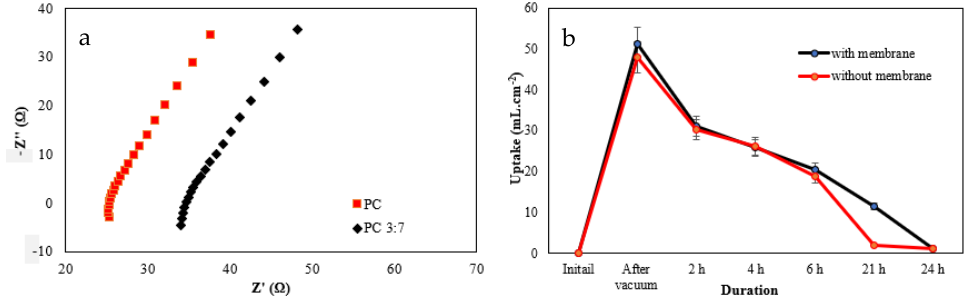
Figure 3. ( a ) Nyquist plots of PC 3:7 textile and PC textile and ( b ) electrolyte uptake and ageing test of PC 3:7 textile and PC textile.